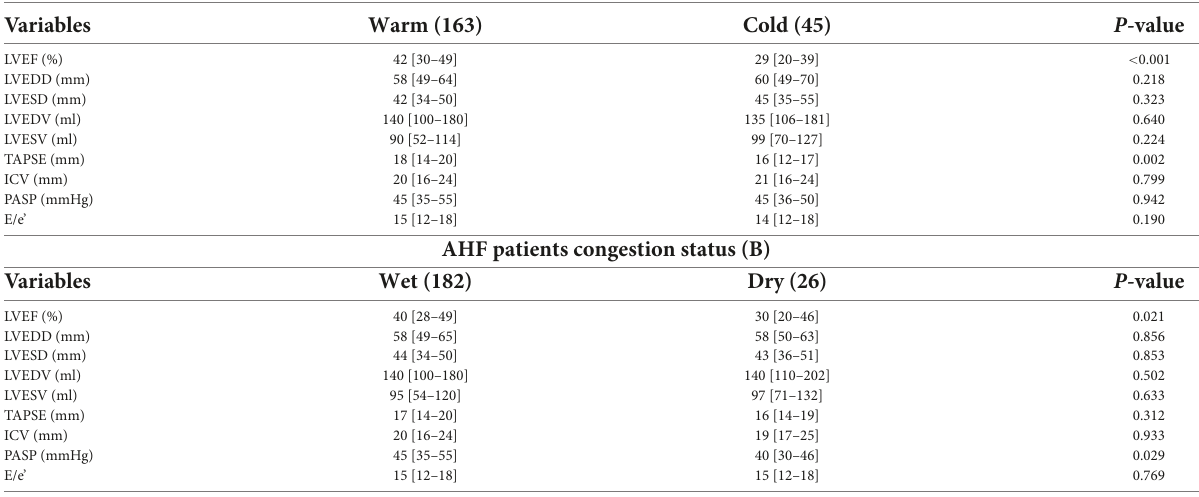
TABLE 2 Echocardiographic differences among warm and cold patients (A) and wet and dry patients